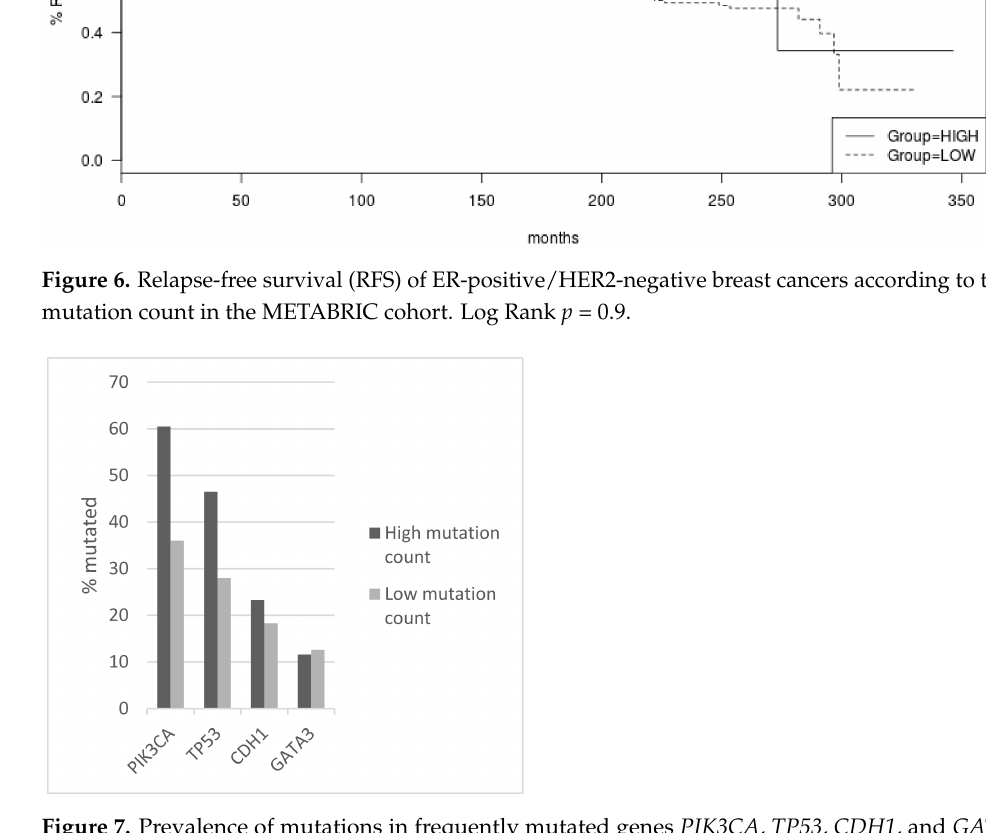
Figure 7. Prevalence of mutations in frequently mutated genes PIK3CA , TP53 , CDH1 , and GATA3 in ER-positive/HER2-negative breast cancers according to total mutation count. The prevalence difference between the groups for PIK3CA and TP53 mutations is statistically significant (Fisher’s exact test p = 0.002 and 0.01, respectively). The prevalence difference between the groups for CDH1 and GATA3 mutations is not statistically significant (Fisher’s exact test p = 0.4 and 0.99, respectively). High mutation count group > 10 mutations/MB; low mutation count group ≤ 10 mutation/MB. Data are from the DFCI metastatic breast cancer study